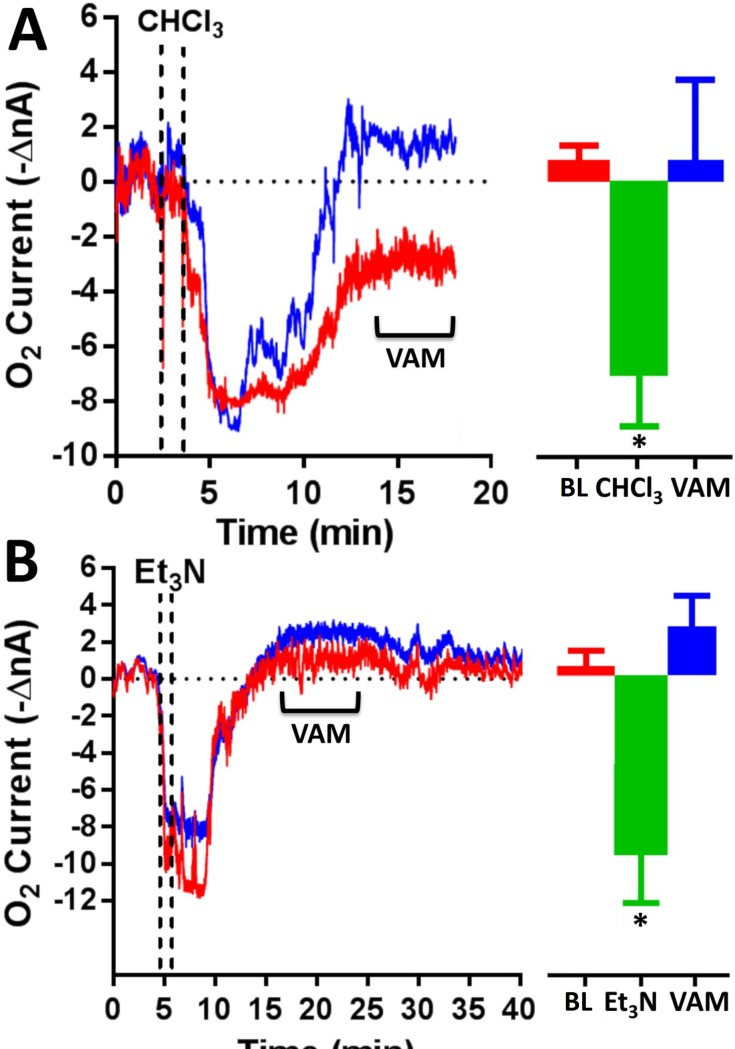
Chloroform and triethylamine effects on O2 currents.Chloroform (A) and triethylamine (B) induced a significant decrease of O2 currents (* = p<0.001 vs baseline). VAM were not constantly observed and only for triethylamine post-treatments currents tended to exceed basal values (p>0.05 vs baseline). # = p< 0.05 vs CHCl3 or Et3N. BL = baseline.